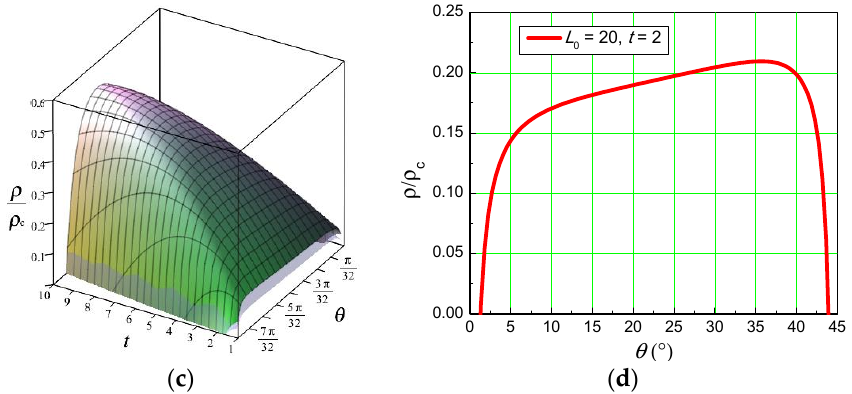
Figure 11. Geometric parameters effects on relative density of the hierarchical RUC: ( a ) t = 2, ( b ) θ = 30 ◦ , ( c ) L 0 = 20, ( d ) L 0 = 20 and t = 2.